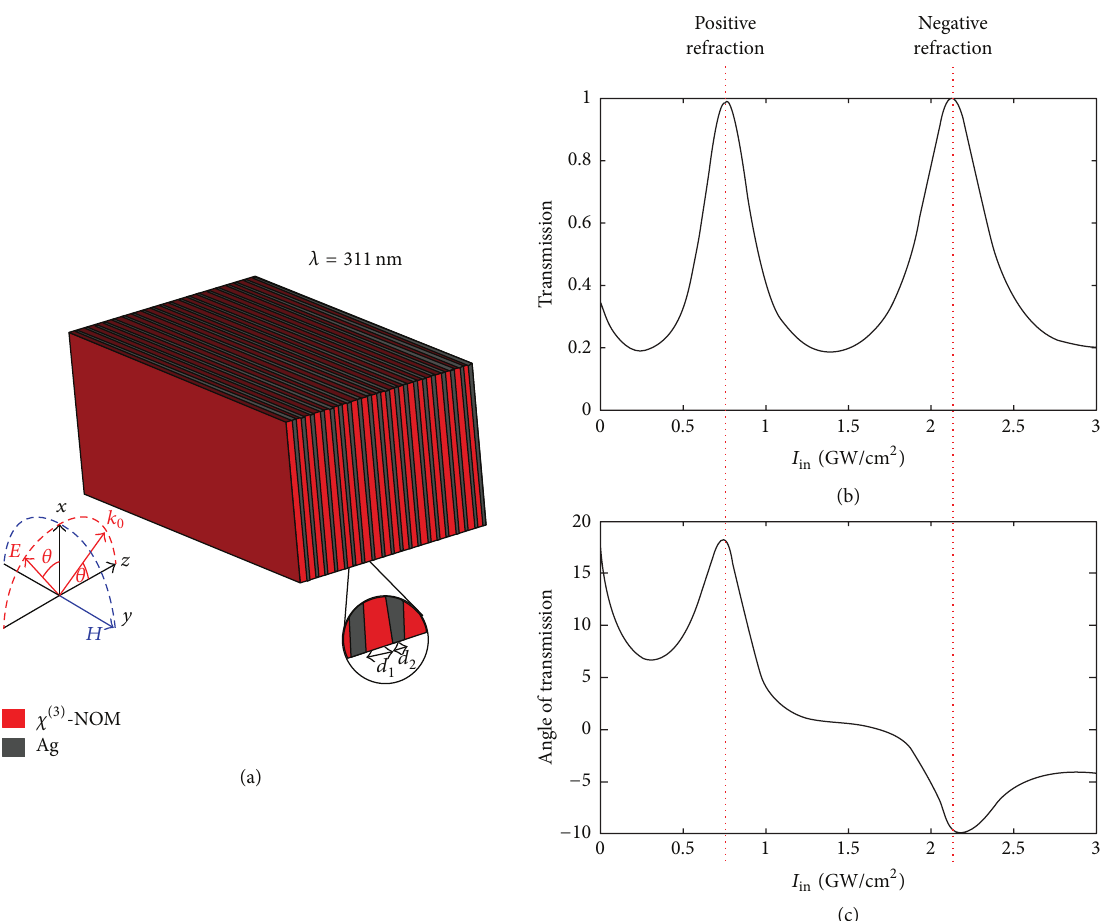
Figure 6: (a) Geometry of a nonlinear hyperbolic metamaterial with tunable response. (b) Transmittance and (c) angle of transmission (in degrees)asafunctionoftheinputintensityforthestructureshowninpanel(a),withthird-orderKerrnonlinearityintroducedinthedielectric layers. The results are computed for incident radiation wavelength of 𝜆 = 311